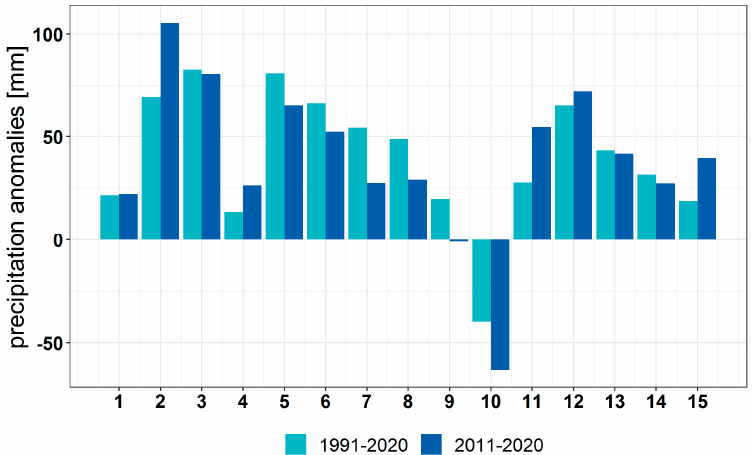
Figure 11. The differences in average annual precipitation over the last 30 years compared to 1951– 1960 decade for the main forest types.